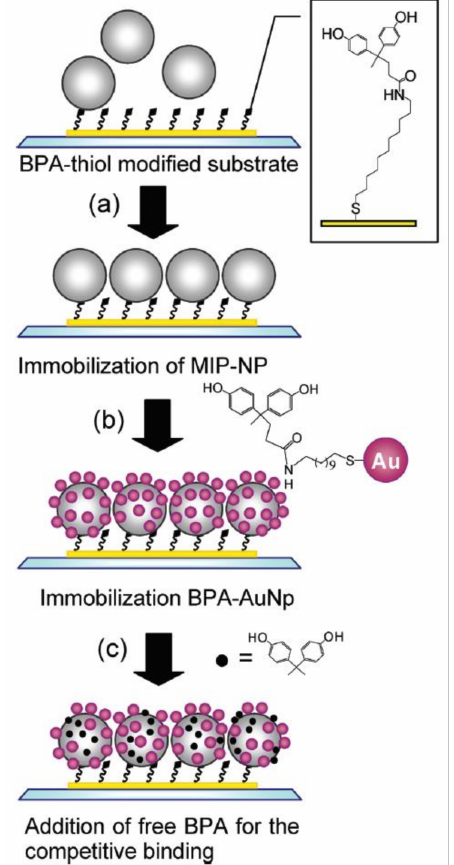
Figure 15. Schematic representation of the immobilization procedure of MIP-Np and BPA-Np on the sensor chip for the BPA detection. (Reprinted with permission from [86]. Copyright 2012 American Chemical